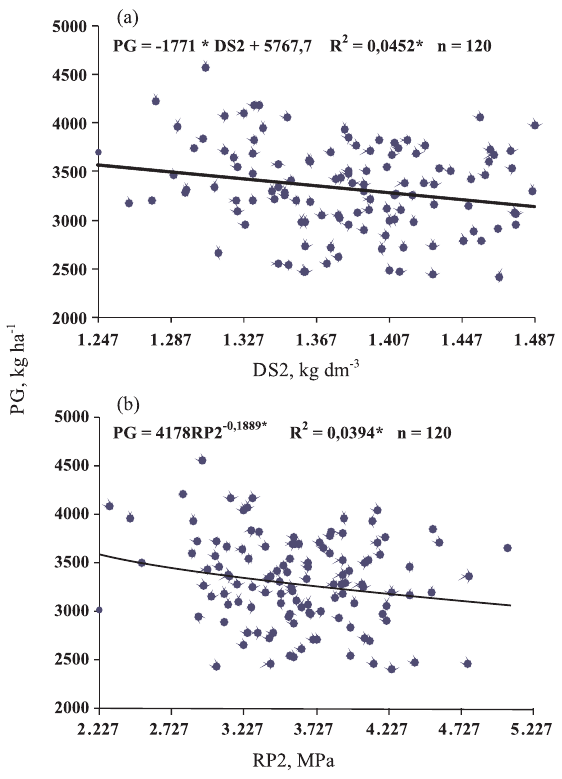
Figura 1. Equações de regressão da produtividade da soja em função de alguns atributos físicos de um Latossolo Vermelho distroférrico de Selvíria